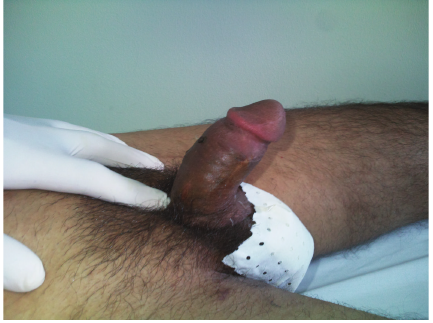
Figure 2: The patient regained his erectile function 4 weeks after the